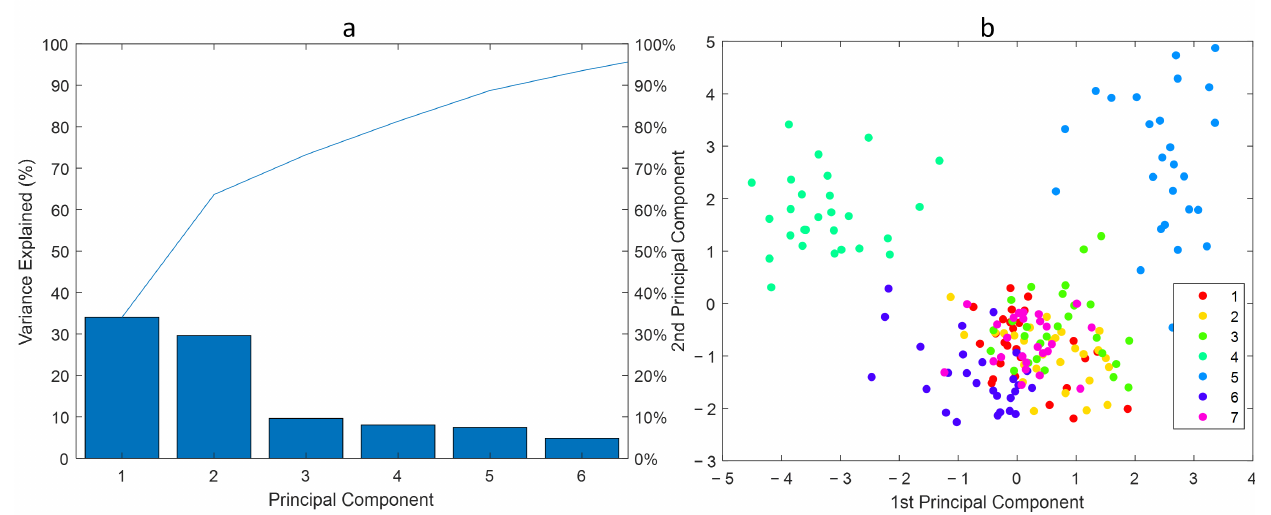
Figure 9. The Pareto plot in subfigure ( a ) shows more than 95% of the variance explained by 6 principal components. The scatter plot in subfigure ( b ) for the first two principal components shows the separation of the test classes 1–7 as per Figure 6.